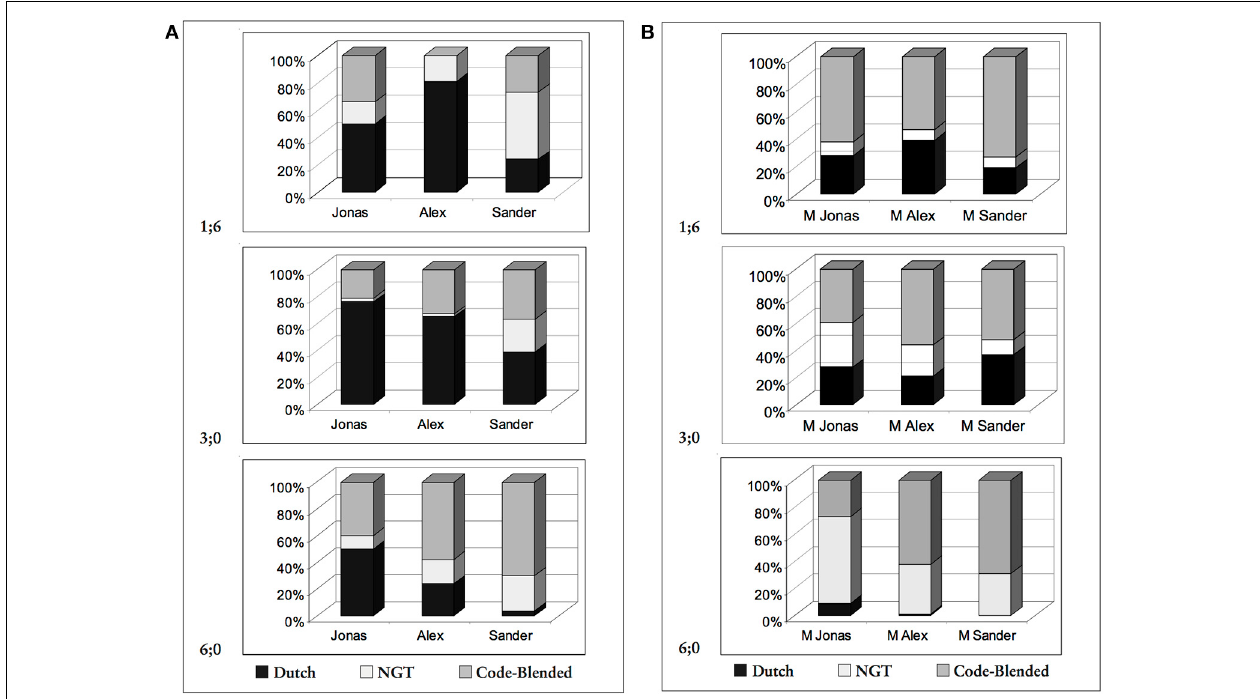
FIGURE 3 | Bimodal bilinguals. Language choice by (A) hearing children and (B) deaf mothers at ages 1;06, 3;00, and 6;00 (van den Bogaerde and Baker, 2009) (Reproduced with permission from Gallaudet University Press).